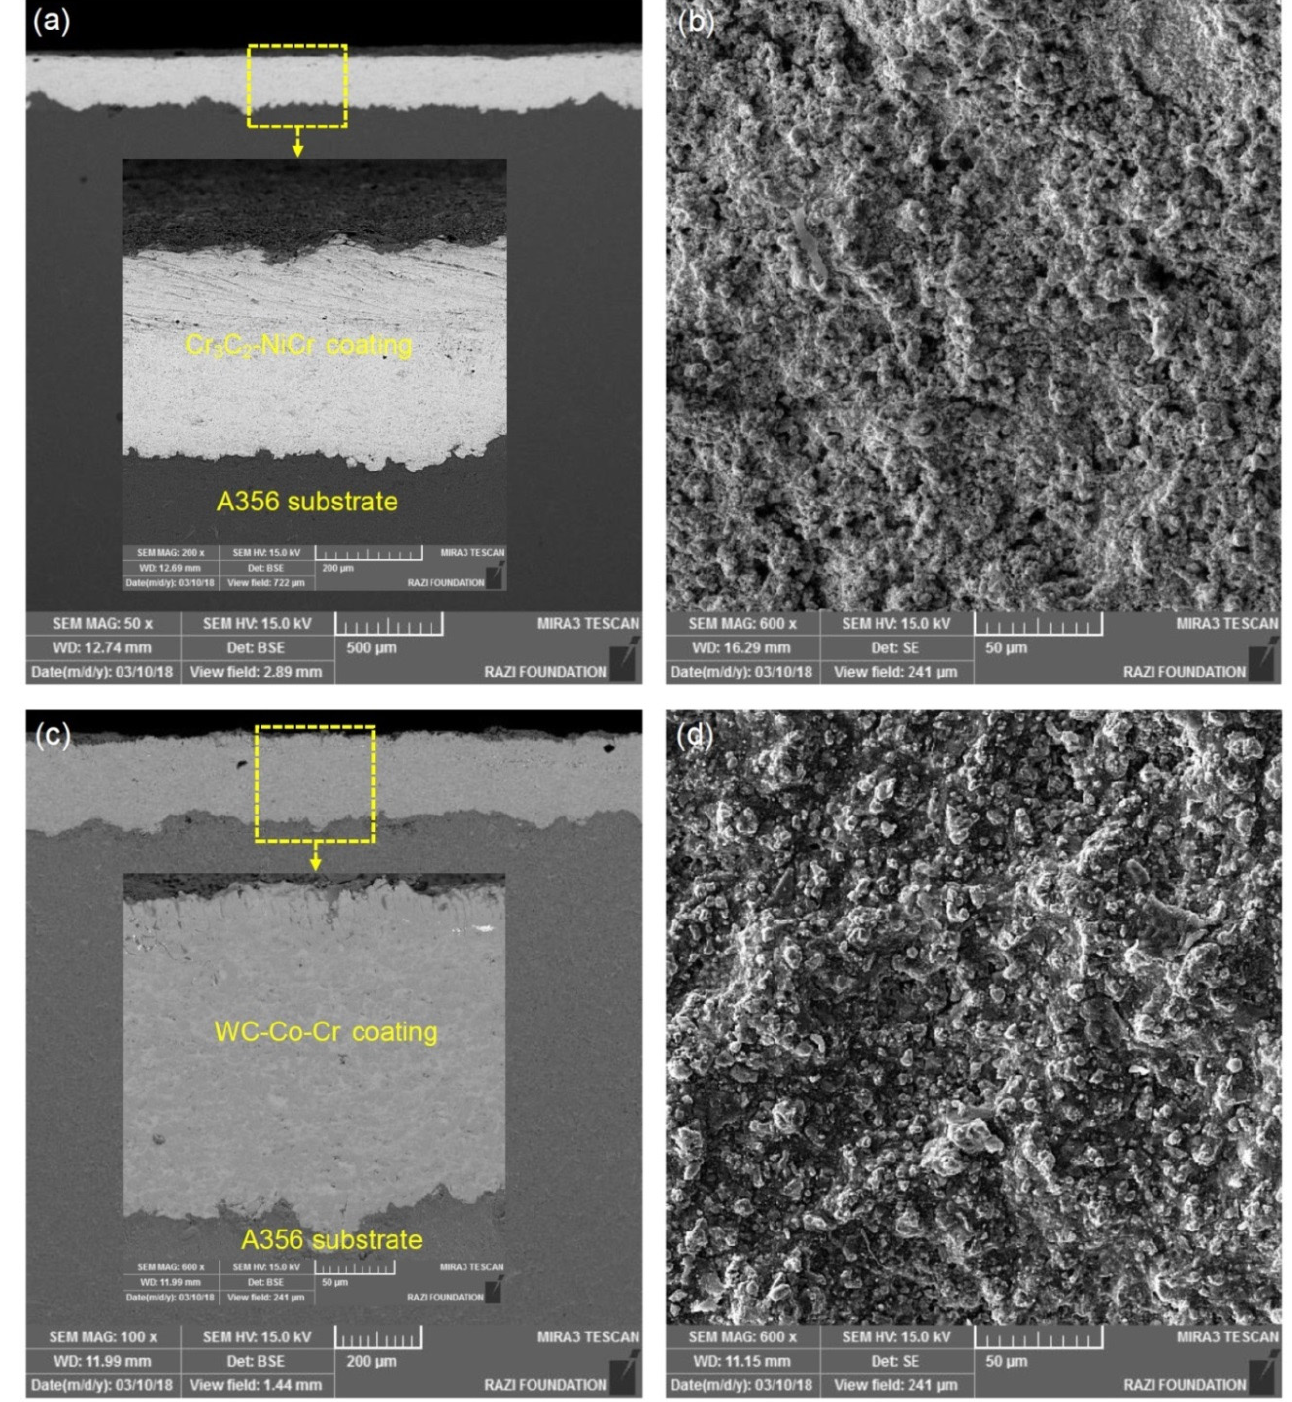
Figure 2. SEM micrographs on the cross-section ( a ) and surface morphology ( b ) of Cr 3 C 2 -NiCr coating and the cross-section ( c ) and surface morphology ( d ) of WC-Co-Cr coating.